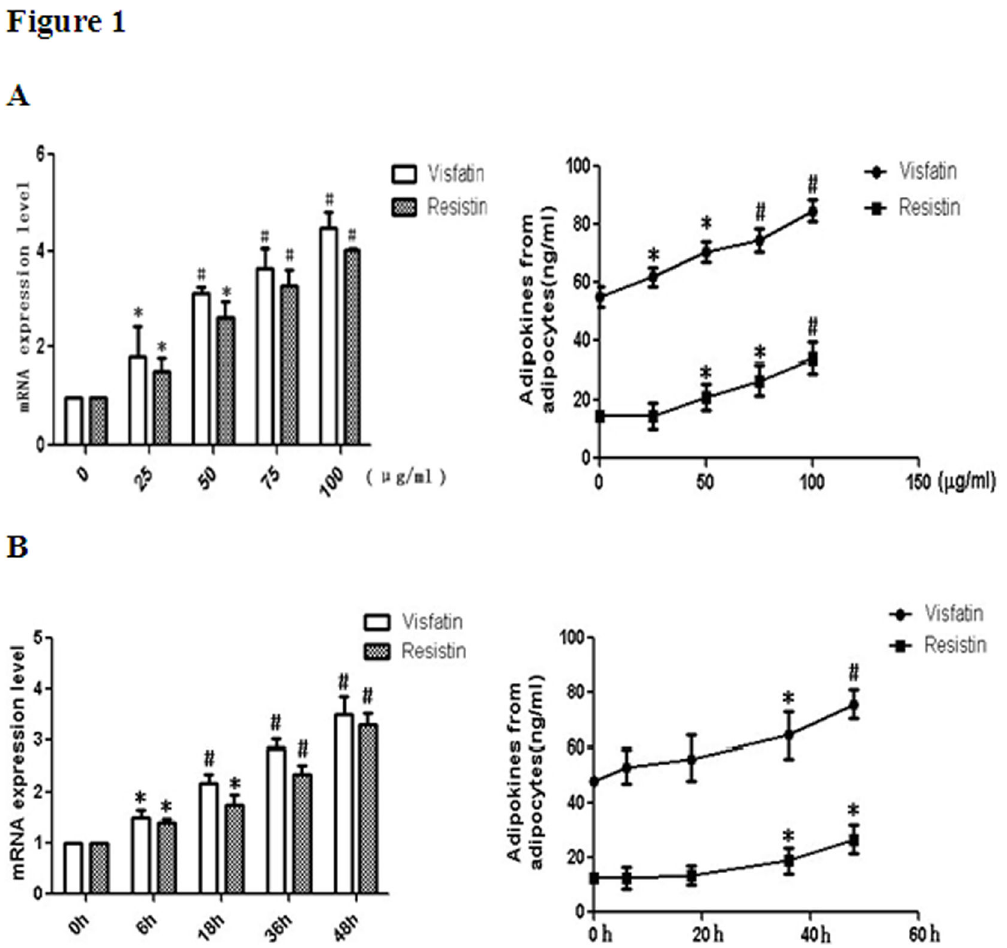
Figure 1. Ox-LDL loading induces the secretion of visfatin and resistin in adipocytes. Differentiated 3T3-L1 adipocytes were incubated in medium containing various concentration of ox-LDL (0, 25, 50（ 75（ 100µg/ml) and 10µg/ml Sandoz 58035 for 48hrs(A); Adipocytes were incubated with ox-LDL (50µg/ml) in a combination of sandoz58035(10µg/ml) for various times(B). At the end of the incubation, the mRNA expressions of visfatin and resistin were evaluated by real-time PCR. The culture media were collected, and the amounts of visfatin and resistin released to the media were analyzed by enzyme-linked immunosorbent assay. * P<0.05, as compared with control; # P<0.01, as compared with control. Data are presented as means ± SD (n =